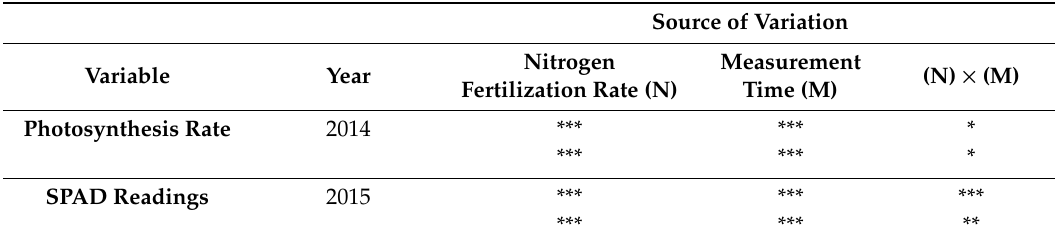
Table 2. Summary of statistical significance from analysis of variance for photosynthesis rate and Soil Plant Analysis Development (SPAD) readings.